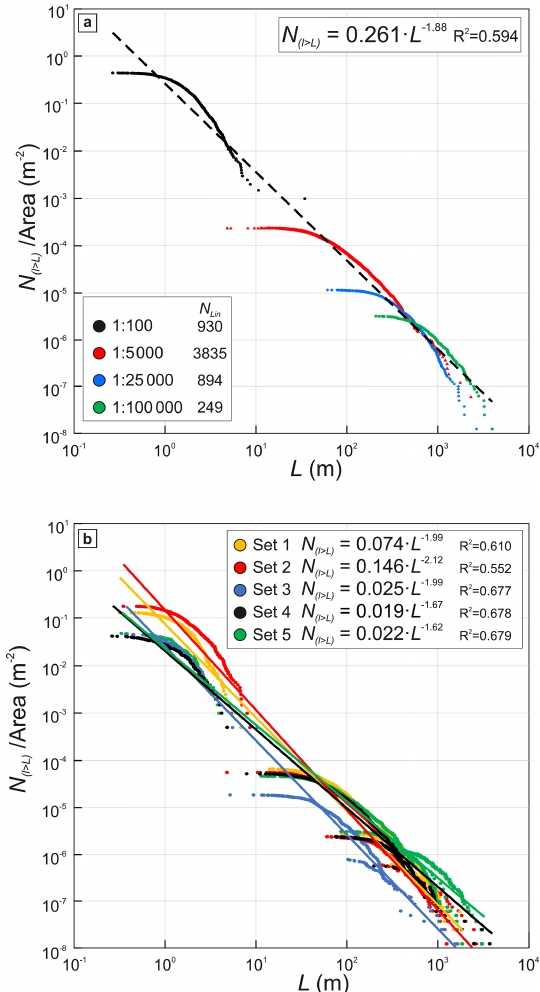
Figure 6. (a) Log-log diagram of lineament length L vs. cumulative number of lineaments N (l>L) per unit area showing the cumulative length distribution for the lineament maps reported in Fig. 3. (b) Log-log diagram as above showing the cumulative length distribu- tion for each orientation